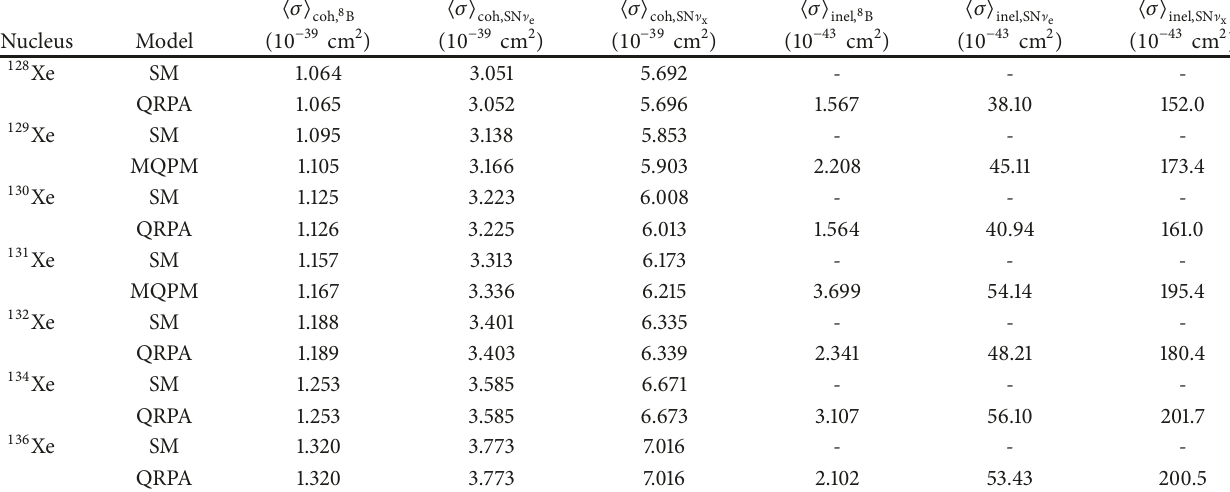
Table 4: Total averaged cross section for 8 B solar neutrinos and electron and muon/tau supernova neutrinos (SN ] xenon targets. The results are shown for calculations in the nuclear shell model (SM) and the QRPA/MQPM formalisms. Cross sections for coherent scattering are given in units of 10 −39 cm 2 and for inelastic scattering in 10 −43 cm 2